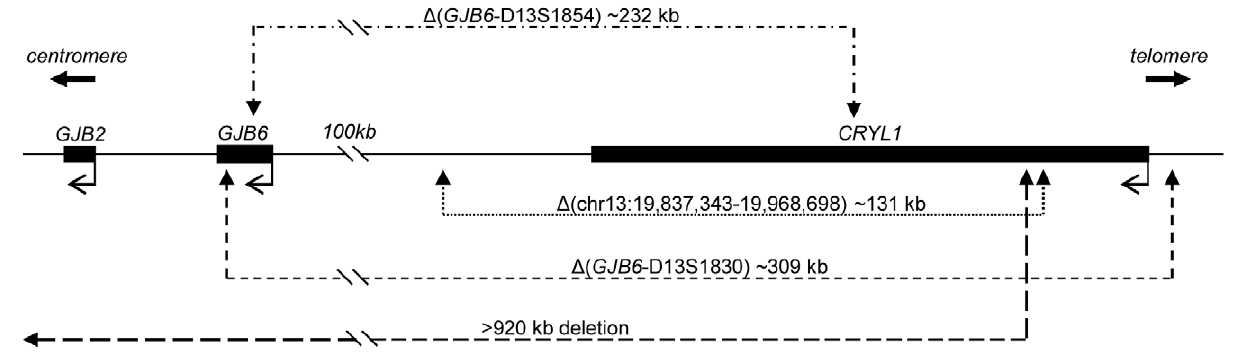
Figure 1. Map of the region on chromosome 13q11-12 disrupted by deletions. The , 365 kb DNA section encompasses three genes (dark boxes), the breakpoints of the deletions (arrowheads) and their range (dashed lines). All elements are drawn approximately to scale. GJB6 and CRYL1 are impacted by three of the four deletions; however GJB2 is directly affected only by the largest deletion. del( GJB6 -D13S1854) and del( GJB6 - D13S1830) are investigated in this study. The transcriptional start sites are shown by bent arrows.